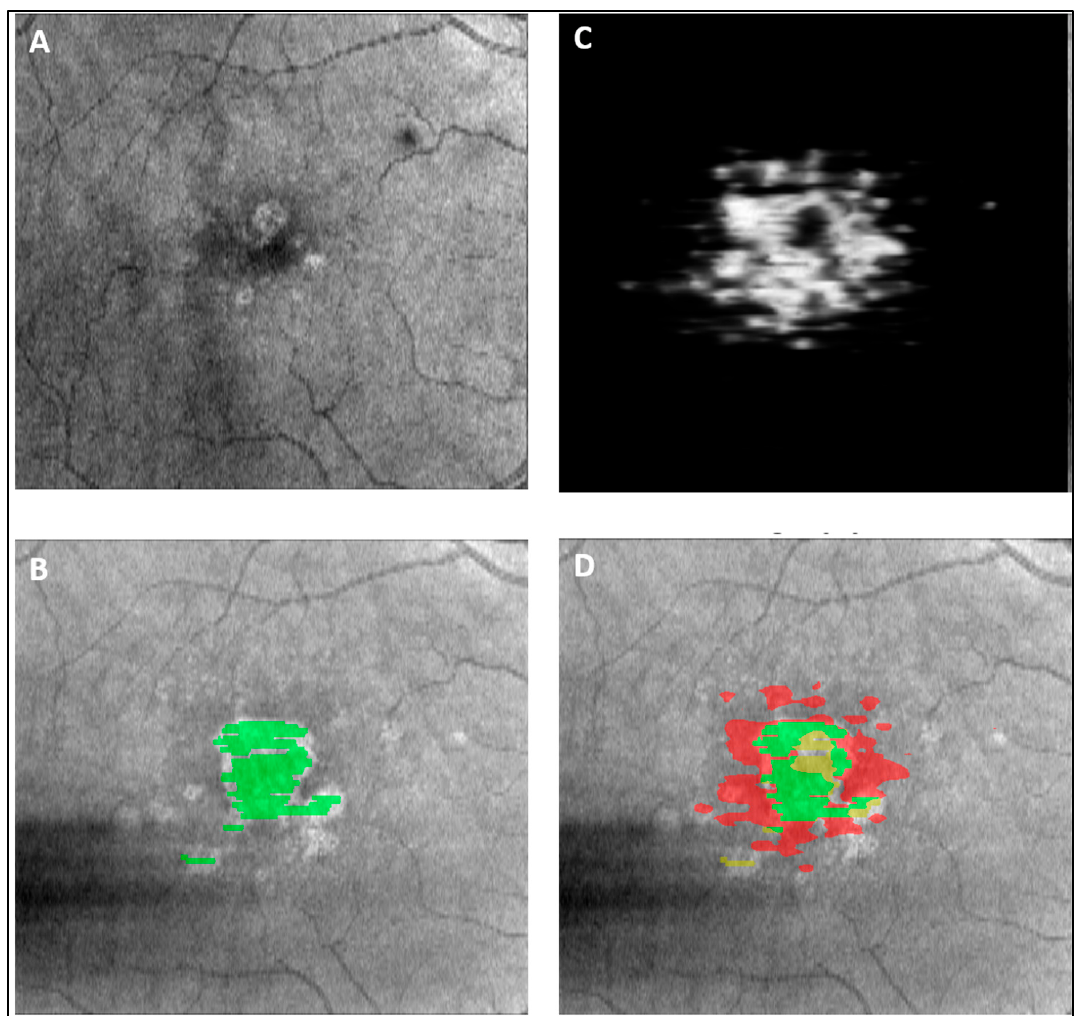
Figure 5. A case example of GA progression on en face OCT from ( A ) baseline scan to ( B ) 5-year follow-up scan (GA area labeled in green). ( C ) en face compilation of DL grayscale output of EZ At-Risk measurement on baseline OCT. ( D ) overlay of baseline DL output and year 5 follow-up GA ground truth showcasing the prediction potential of baseline EZ At-Risk measurement where green region indicates successful prediction of GA at year 5, red indicates false positive GA prediction for year 5, and yellow indicates false negative GA prediction at year 5. GA: geographic atrophy; OCT: optical coherence tomography; DL: deep learning; EZ: ellipsoid zone.